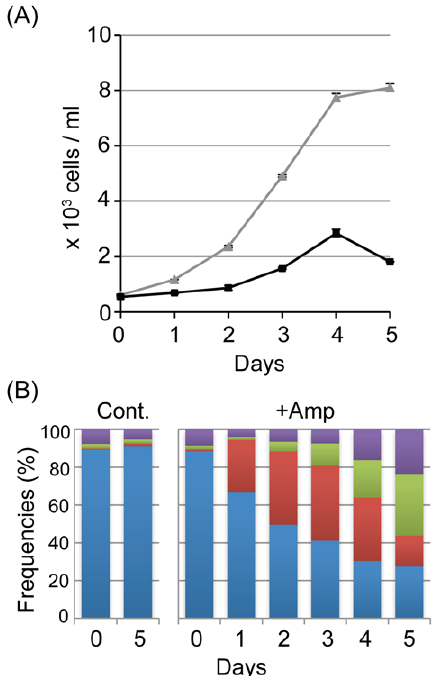
Figure 5. Effects of ampicillin on Closterium cell growth and division. ( A ) Growth curves of untreated cells (triangle) and of 100 m M ampicillin-treated cells (square). Measurements were performed in duplicate. ( B ) Changes in the frequencies of the four cell types: cells with two chloroplasts (Blue), cells with one chloroplast (Red), elongated cells with irregular chloroplasts (Green) and dead cells (purple). Measurements for untreated cells (Cont) at zero and five days and for ampicillin-treated cells ( + Amp) are shown.